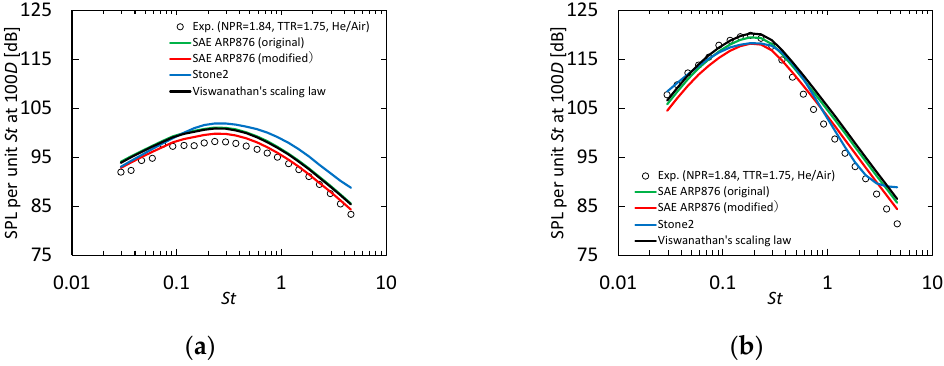
Figure 5. Comparison between the predicted and measured SPLs for a single heat-simulated jet operated at the jet velocity of 392.8 m/s and the jet total temperature ratio of 1.75: ( a ) θ = 90°, ( b ) θ = 150°. The statistical differences between the predicted and measured SPLs were